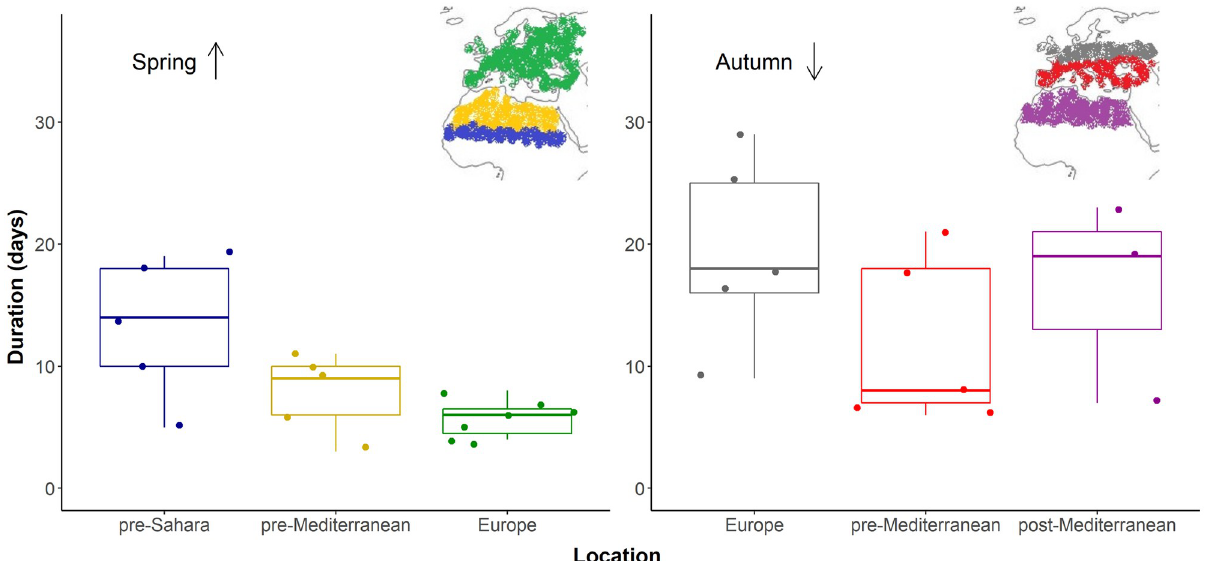
Fig 5. Days spent at stopovers located in different geographic locations during spring and autumn migration. In spring, blue/bottom = pre-Sahara (stopovers before the Sahara Desert), yellow/middle = pre-Mediterranean (stopovers in North Africa) and green/top = Europe ( stopovers in Europe before arriving at breeding grounds) . In autumn, gray/top = Europe ( stopovers in Europe after leaving breeding grounds) , red/middle = pre- Mediterranean (stopovers in southern Europe , before crossing the Mediterranean Sea) and purple/bottom = post-Mediterranean (stopovers in North Africa). The direction of arrows represents the direction of migration.